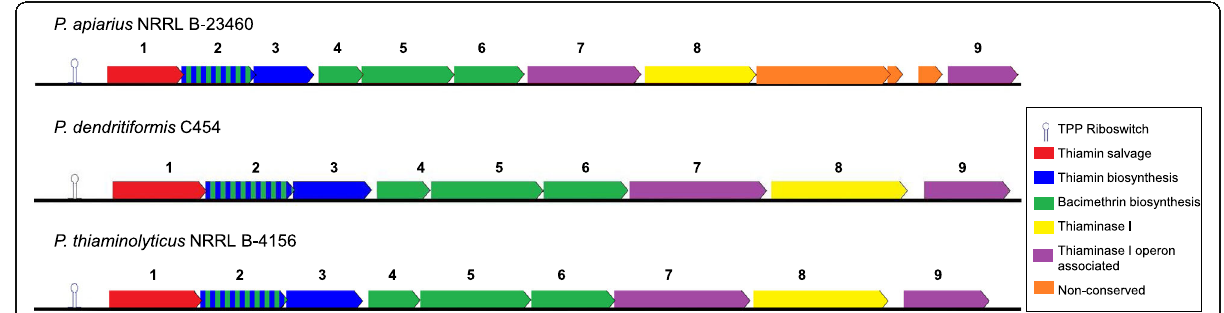
Fig. 4 Putative thiaminase I operons in the three Paenibacillus species. Annotations of conserved genes shared amongst the three species are as follows (1) thiM; (2) thiD ; (3) thiE ; (4) glycosyltransferase; (5) thymidylate synthase; (6) methyltransferase; (7) yzgD NUDIX hydrolase; (8) thiaminase I and (9) HAD hydrolase. Three genes in P. apiarius B23460 that are not conserved include a putative transcriptional regulator and two genes of unknown function. The operons may be under the control of a putative thiamin pyrophosphate binding riboswitch, upstream of thiM . Genes are color-coded based on proposed